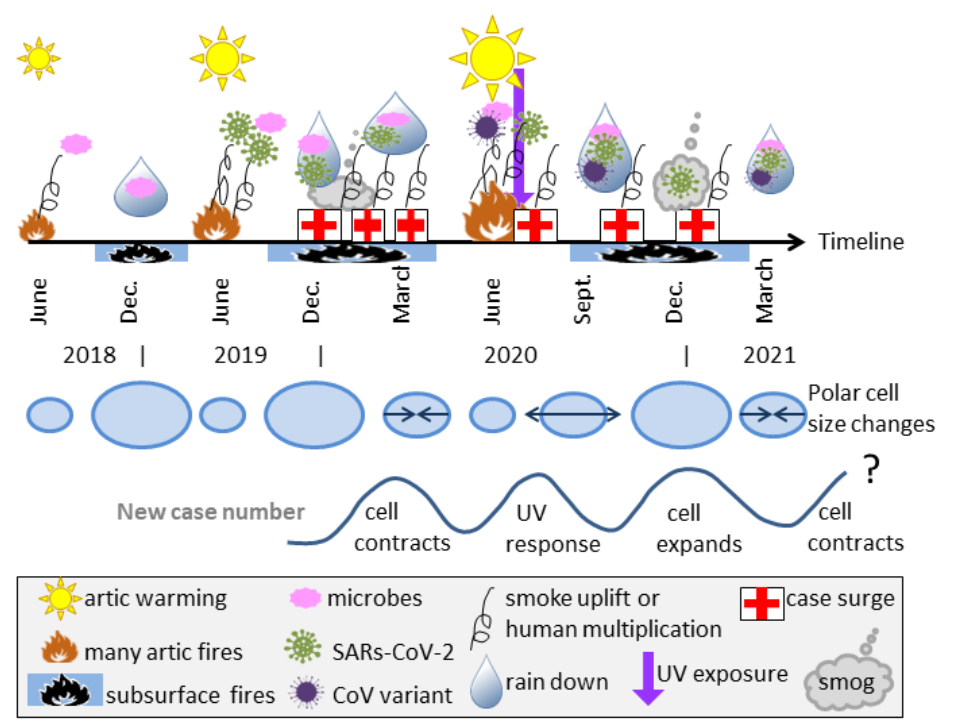
Figure 9. Schematic of the proposed time evolution for COVID-19 in the Northern Hemisphere. The date line is non-linear and approximate. Top row of symbols shows the inferred timing of various natural processes, where the symbols are described in the legend (grey box at bottom). Middle row of blue ovals shows the sizes of the North Polar cell connected with seasons, and whether it is expanding or contracting (arrows). Grey curve shows the wavelike number of case increases and how these are connected with the Polar cell cycles and human UV response. However, the UV peak is only expected for areas with seasonal UV changes. In our model, cyclically occurring natural processes both lead up to the pandemic and promote its longevity. Major pandemics are rare because once any given region of permafrost is melted and releases its particular microbes, this locality is depleted.